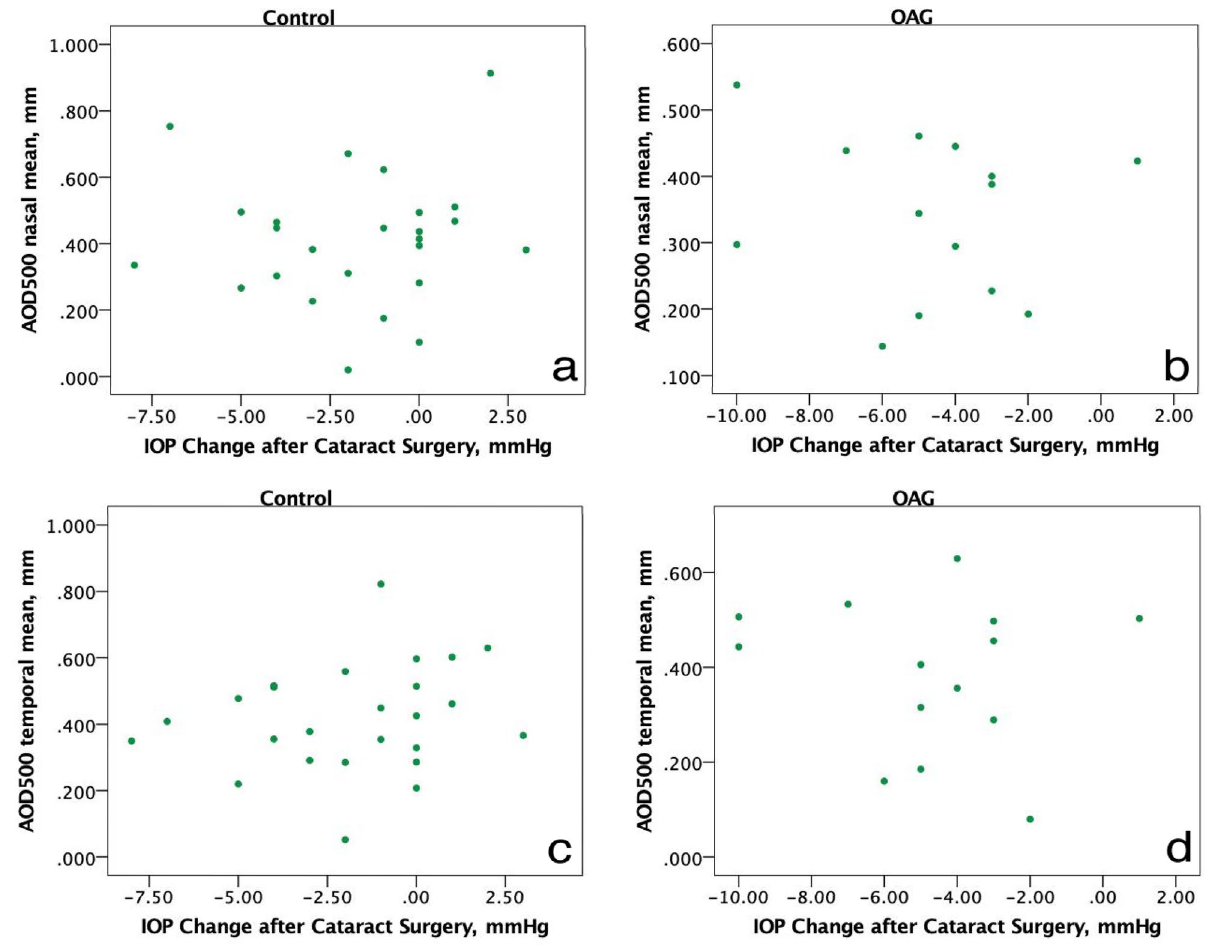
Figure 2. Correlations between IOP and preoperative AOD500 nasally ( a , b ) and temporally ( c , d ). IOP change postoperatively did not correlate with AOD500 in both groups. (Illustration made using IBM SPSS Statistics for Windows, Version